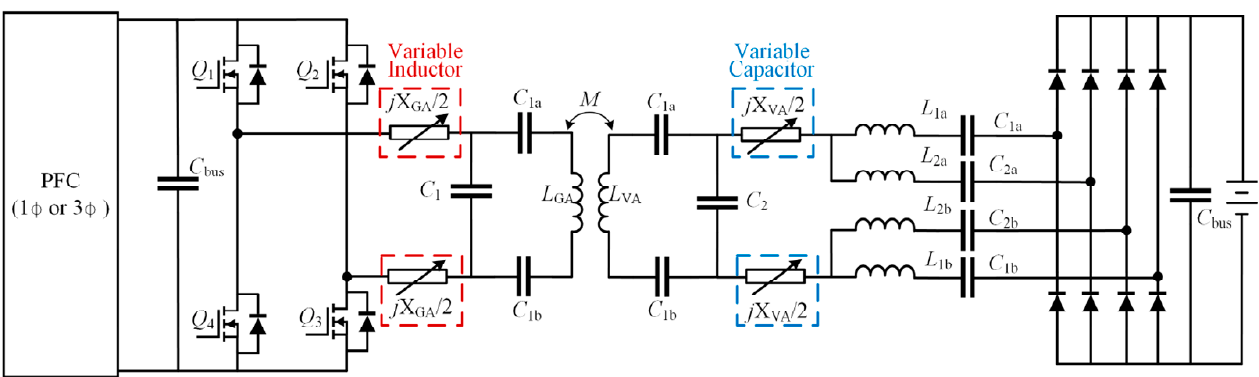
Figure 7. TMN topology for WPT3/Z2.